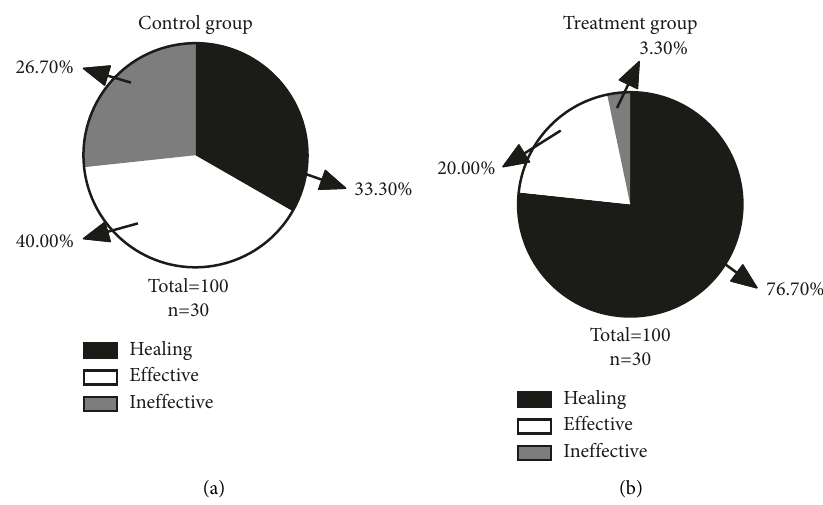
Figure 1: (a) efficacy of the control group and (b) efficacy of the treatment group.